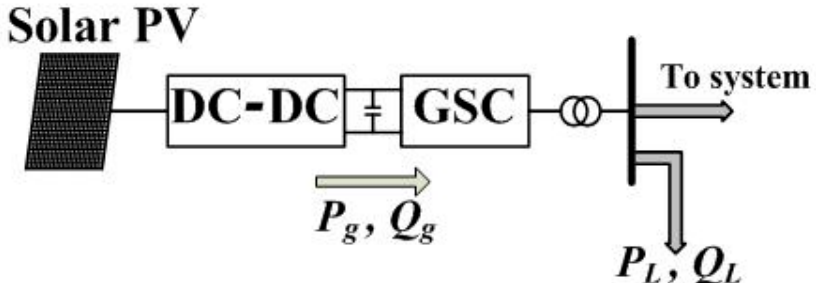
Figure 1. Connection diagram of a solar PV farm to the system.